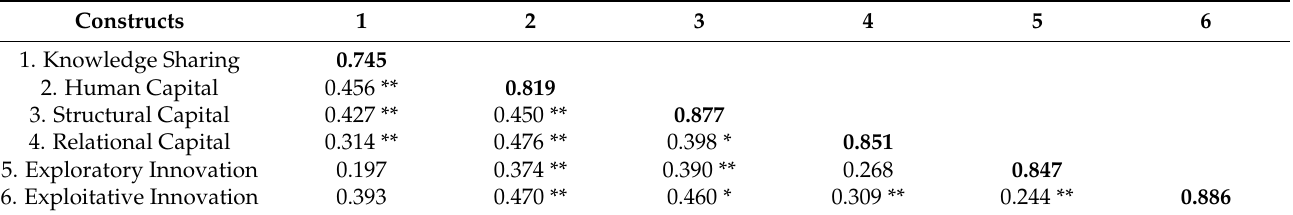
Table 3. Square roots of AVE and correlation